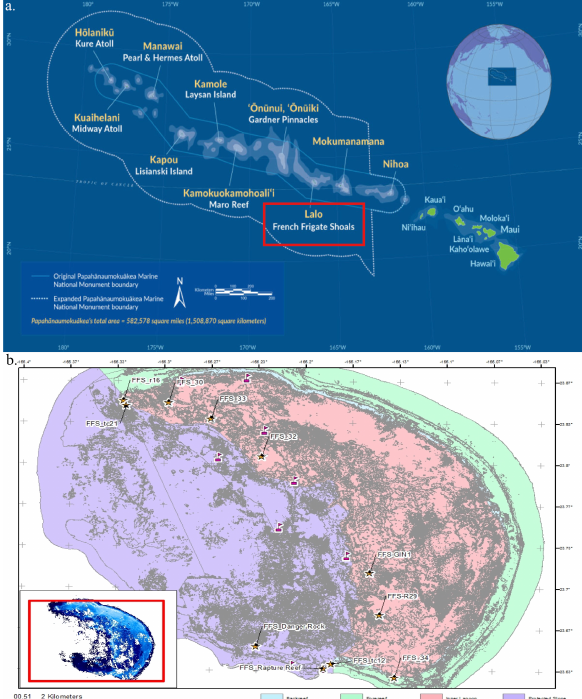
Figure 1. Site images showing a) the islands and atolls within the Papahānaumokuākea Marine National Monument and, b) the specific locations of long-term monitoring sites (indicated by star symbols) at French Frigate